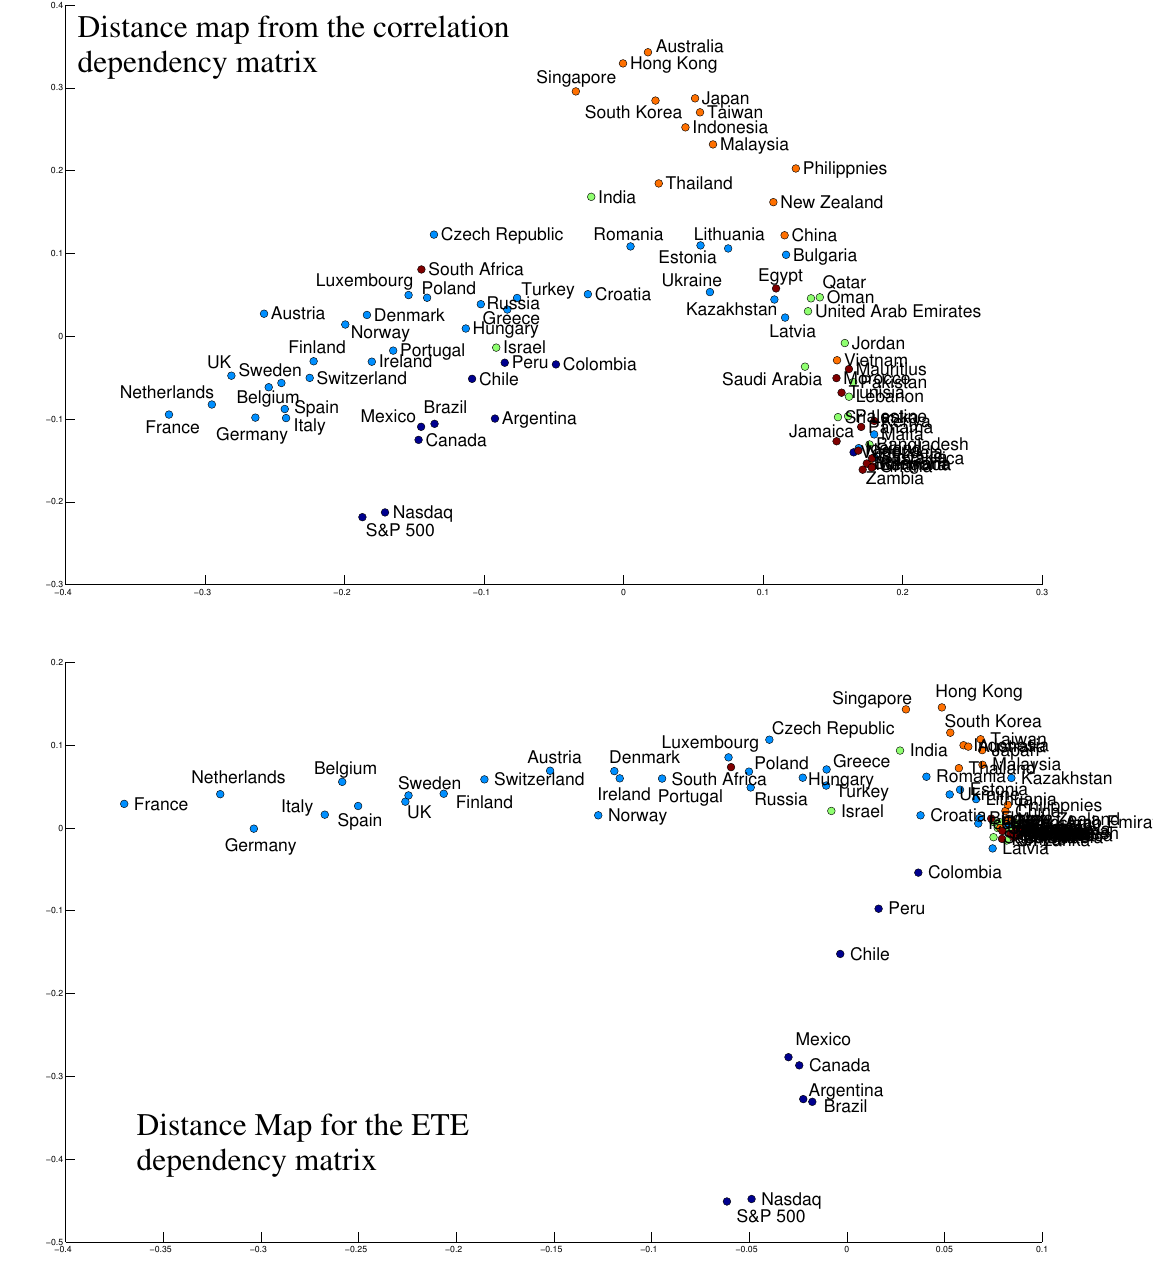
Figure 13. Distance maps of the correlation and ETE dependency